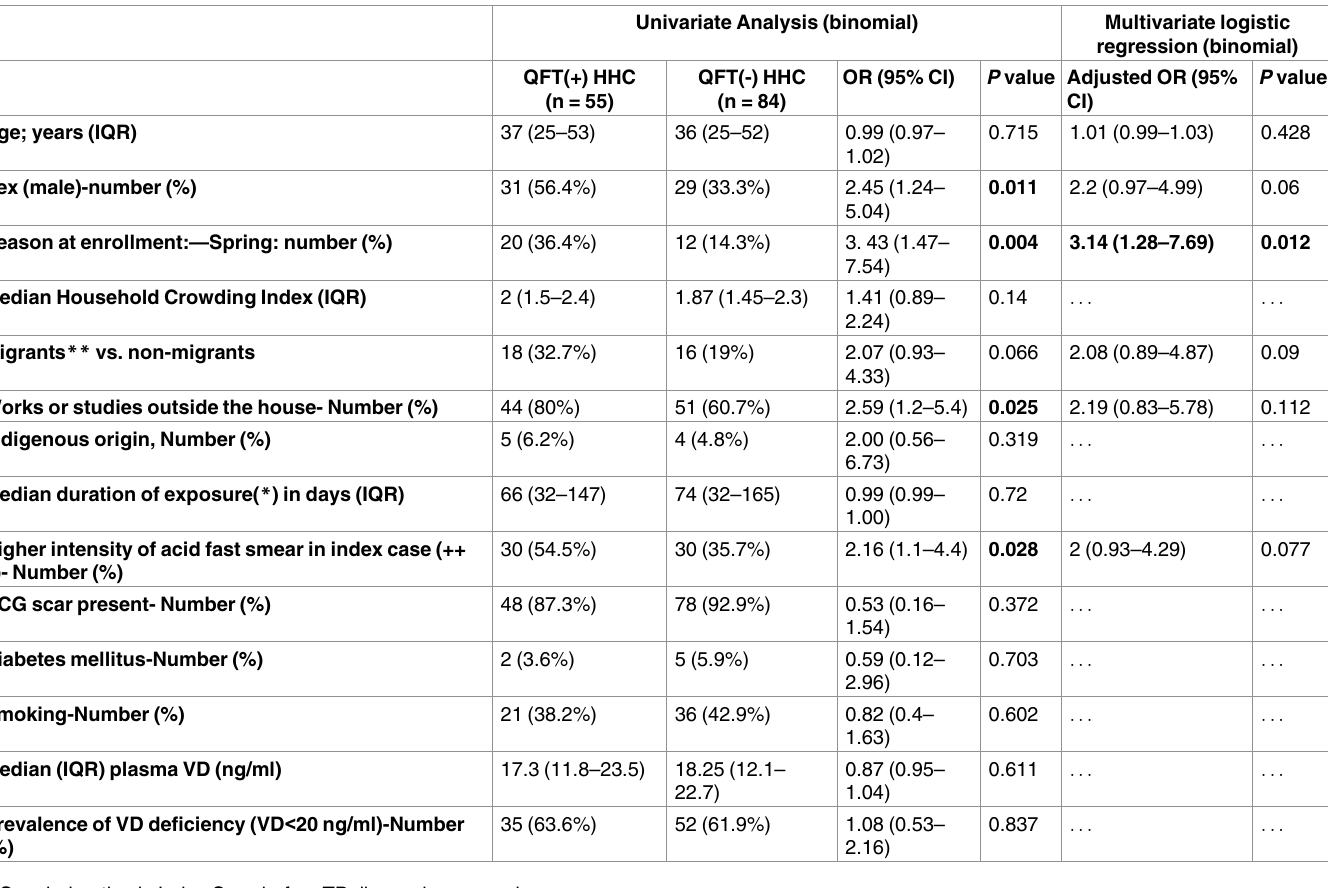
Table 2. Regression Analysis of associations with latent TB infection among household contacts (n =